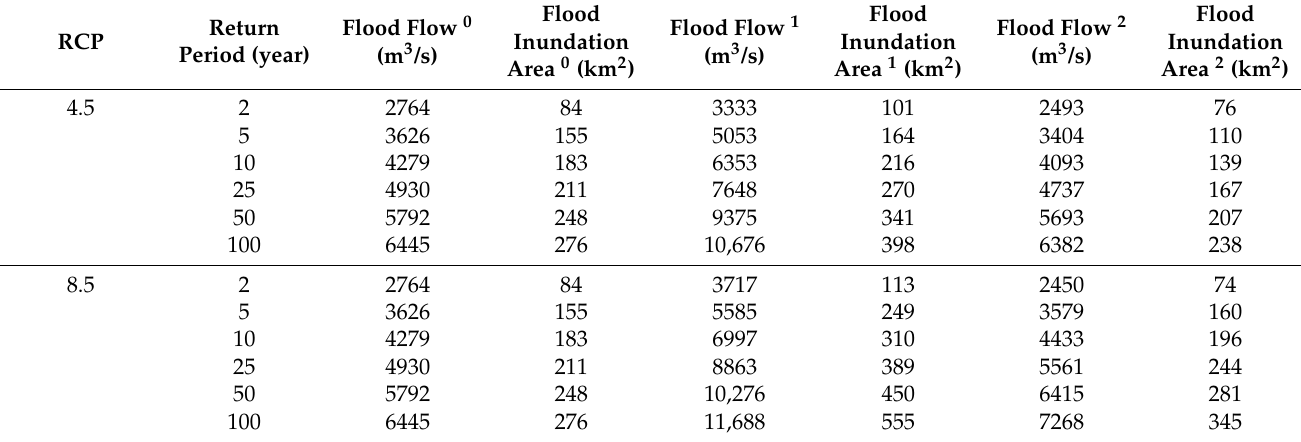
Table 3. Flood peak flow and the inundation area for three climate